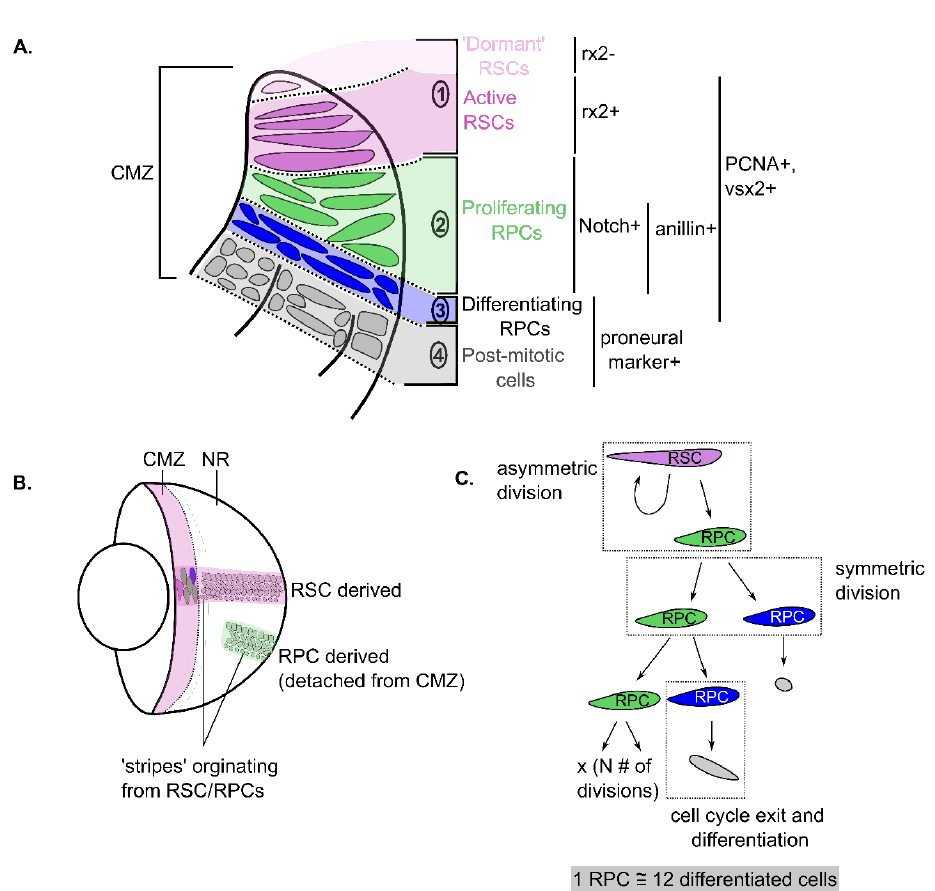
Figure 2. Retinal stem and progenitor cells’ characteristics in the CMZ of teleost fish and Xenopus . ( A ) Schematic of the four main compartments of the CMZ niche. The first region at the tip (1) contains dormant and active retinal stem cells (RSCs) ( pink ) that are either rx2- or rx2+ . In the second region are highly proliferative retinal progenitor cells (RPCs) that are distinguished by expression of a different subset of markers (i.e., Notch and Anillin ). The third region is composed of RPCs poised to differentiate since they co-express proliferating and pro-neural genes. All actively proliferating RSC/RPCs express markers for proliferation, including PCNA and vsx2 . In the fourth region are post-mitotic cells that have differentiated. This schematic is adapted from those seen in [6,7]. ( B ) Schematic of the whole eye showing the CMZ region labelled in pink in an annulus adjacent to the lens. Labelled populations of cells derived from RSCs produce continuous stripes from the CMZ (named ArCoSs), whereas stripes produced from RPCs produce disconnected patches called terminated patches. This schematic is adapted from data visualized in [41,46,48]. ( C ) Example of the different events occurring in the proliferation and differentiation of RSCs/RPCs in the CMZ. An asymmetric division gives rise to two different daughter cells. An RSC that asymmetrically divides gives rise to one RPC and one RSC to maintain self-renewal. Conversely, a symmetric division results in the progeny of the same identity (i.e., two RPCs). RPCs will eventually stop proliferating and differentiate after a certain number of divisions, on average producing 12 differentiated cells. Pink cells = RSCs (zone 1 cells), green cells = proliferating RPCs (zone 2 cells), blue cells = RPCs committed to differentiation (zone 3 cells) and grey cells = differentiated cells. Adapted from data presented in